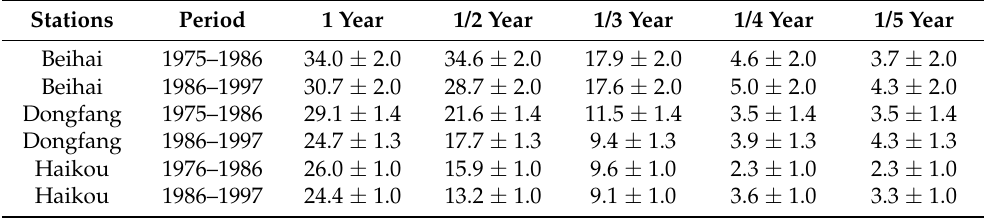
Table 7. Temporal variations in amplitudes (unit: mm) of the seasonal and subseasonal cycles in K 1 tides at Beihai, Dongfang and Haikou. Amplitude errors are calculated based on 95% confidence intervals